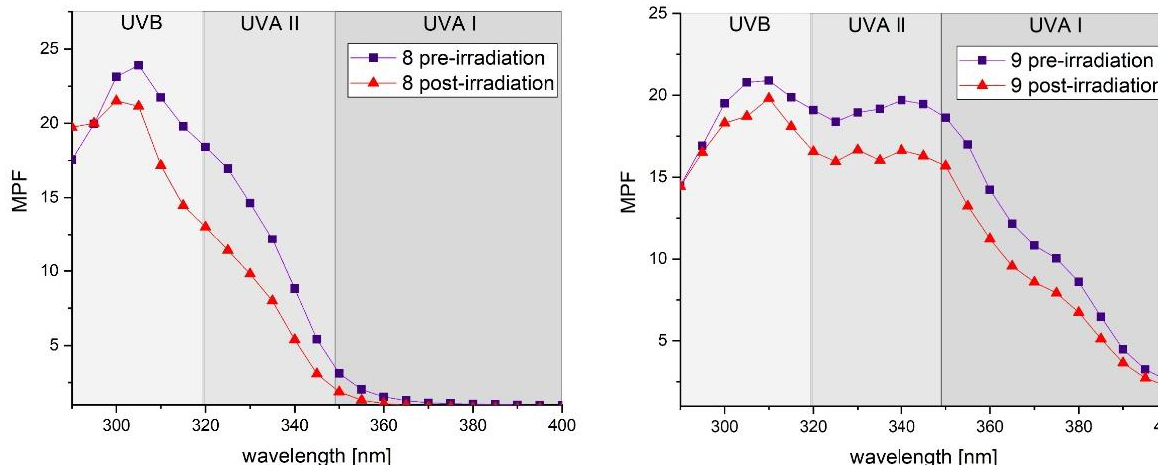
Figure 6. UV absorption spectra of compounds 8 and 9 obtained in pre-irradiation conditions and 1 h post-irradiation with solar light simulator conducted at 500 W/m 2 in 12.5% ( w / w ) cosmetic formulations. Table 4. The changes in photoprotective activity of compounds 8 and 9 after irradiation with solar light simulator at 500 W/m 2 .